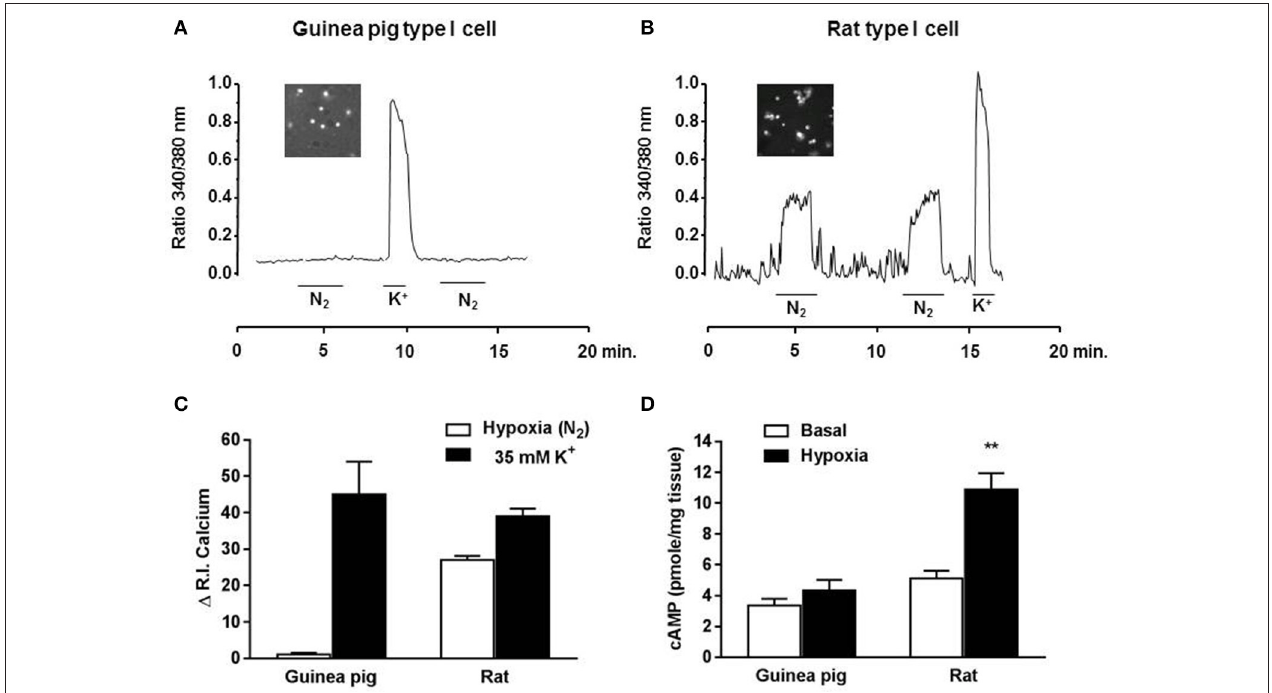
FIGURE 4 | Intracellular Ca 2 + response to hypoxia and high external K + in isolated chemoreceptor cells from guinea pig and rat CB. (A) Sample recording obtained in a guinea pig type I cells from the microscope field (insert) showing the lack of response to the hypoxic stimuli and the increase elicited by perfusion with 35 mM K + solution. (B) Shows the oscillatory behavior of the intracellular Ca 2 + levels in normoxia and the moderate sustained increase elicited by a hypoxic solution and by perfusion with 35 mM K + solution from a rat type I cells. In every cell the fluorescence signal was integrated as a function of time (running integral; RI), showed in (C) . Mean ± SEM of the RI in 16 type I cells from 3 guinea pigs and 29 type I cells from 2 rats. (D) Levels of cAMP from guinea pig and rat CB in normoxic and acute hypoxic conditions. Data expressed as mean ± SEM; n = 6; ** p < 0.01 vs.